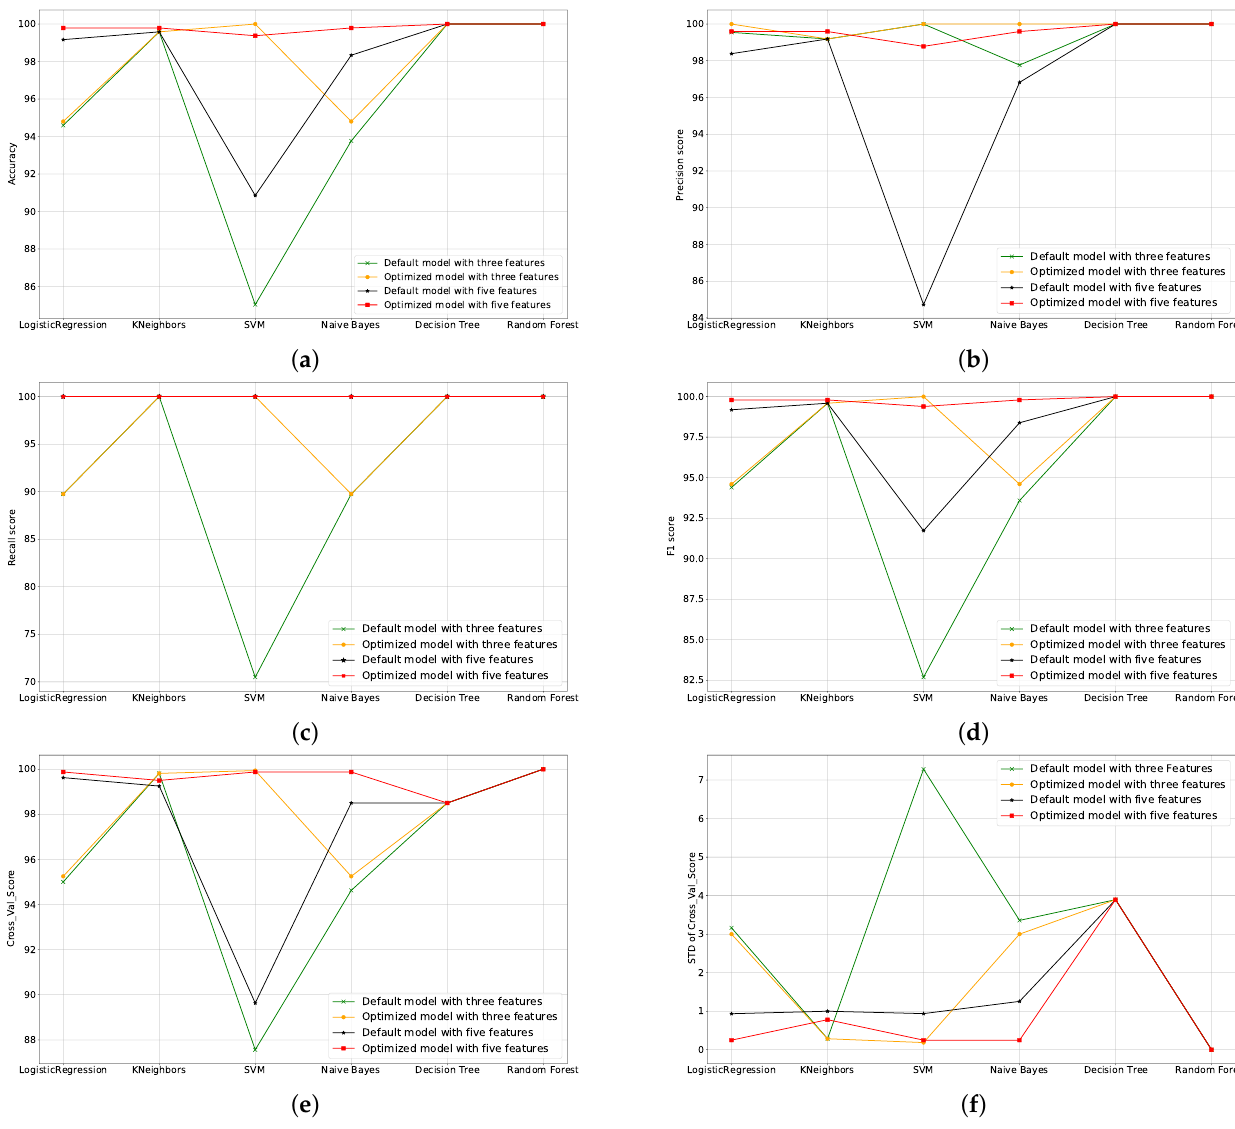
Comparison of various models' performance(Zoomed In For Clarity)